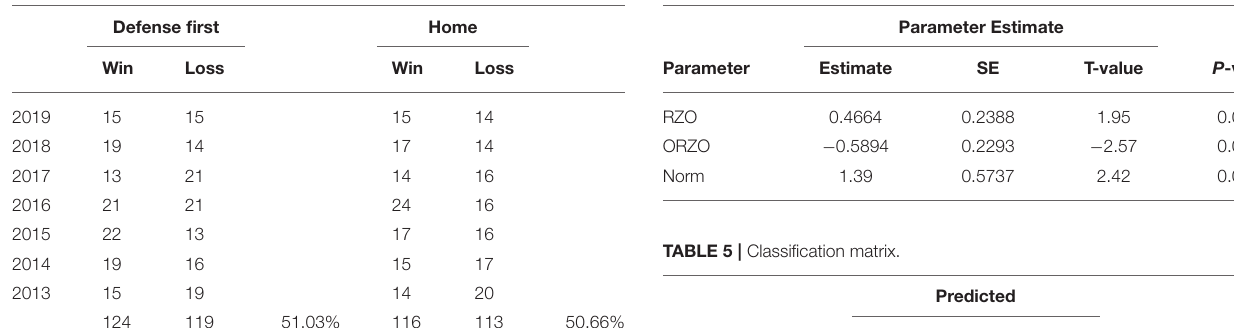
TABLE 4 | Logistic regression parameters.